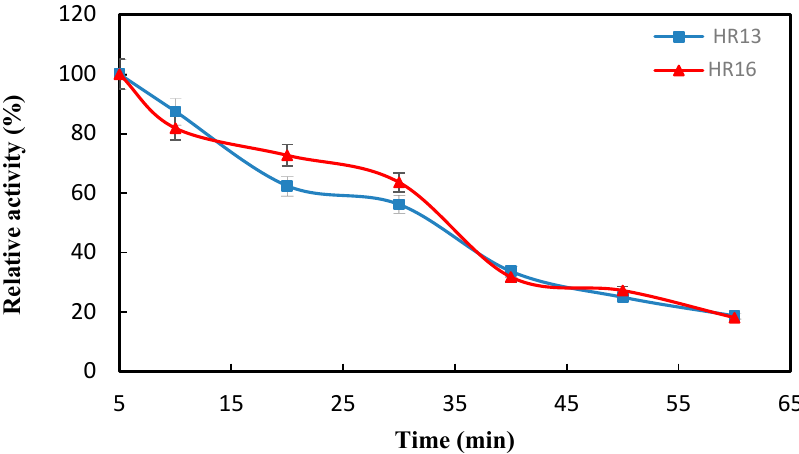
Figure 7. Irreversible inactivation of the α -amylase enzyme in HR13 ( (cid:4) ) and HR16 ( (cid:78) ) after different time periods of incubation at pH